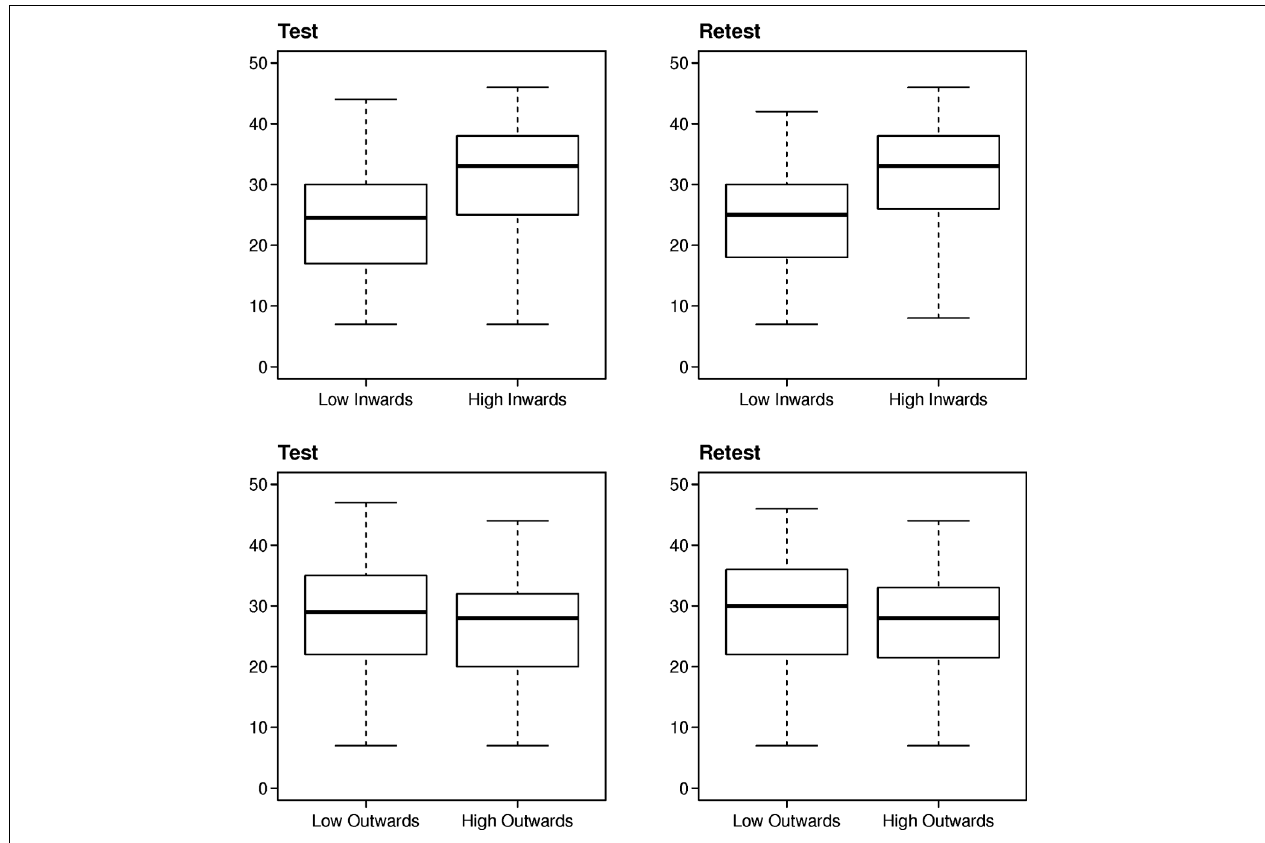
FIGURE 3 | Distributions of Self-centric engagement (SCE) and Other-centric engagement (OCE) scores. The box plots show that SCE scores are more separated between high and low inward than OCE scores.